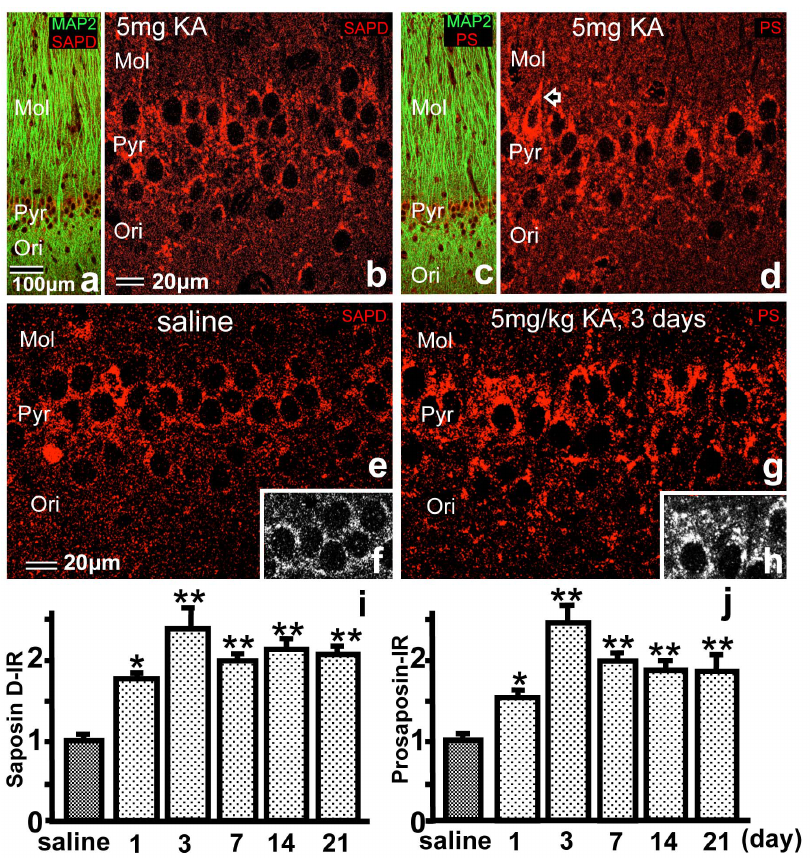
Figure 2. a–d: Light micrographs of the hippocampal CA1 neurons stained with anti-saposin D (a, b) or anti-PS IgG (c, d) showing the PS-IR 3 days after 5 mg/kg KA injection. The dendritic structure of the CA1 region was stained green with an anti-Map II antibody (a, c). b and d show higher-magnification images of the pyramidal layer (Pyr) shown in a and c, respectively. The arrow indicates an interneuron with a slender nucleus and very intense PS-IR cytoplasm (d). e-h: Light micrographs of the hippocampal CA1 neurons of normal controls (e) and animals 3 days after 5 mg/kg KA injection (g). f and h are black-and-white images of the pyramidal layer (Pyr) shown in figures e and g, respectively, which were used for the NIH Image analysis. (i, j) Bar 5 100 m m (a, c) and 200 m m (b, d–h). i, j: The ratio of PS-IR in the hippocampal CA1 region after injection of KA or saline. PS-IR was semi-quantified using NIH image analysis. The ratio of PS-IR was significantly higher on days 1, 3, 7, 14 and 21 after KA injection compared with controls injected with saline ( * p , 0.05, ** p , 0.01). Mol, stratum moleculare; Rad, stratum radiatum; Ori, stratum